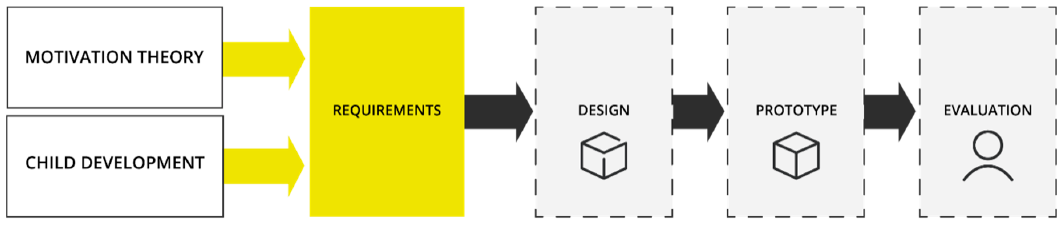
Figure 1. Design process based on the theory on motivation and child engagement and child developmental psychology.